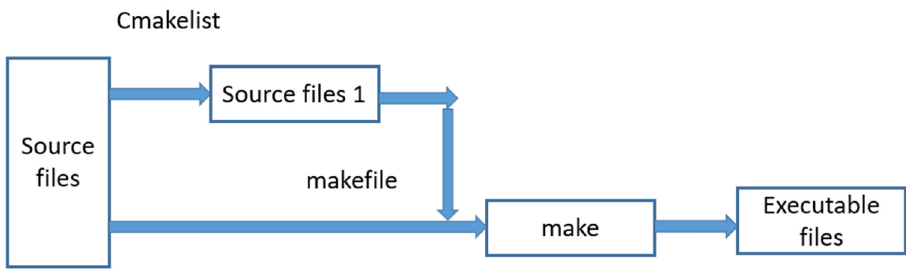
Figure 3. Algorithm transcoding process.